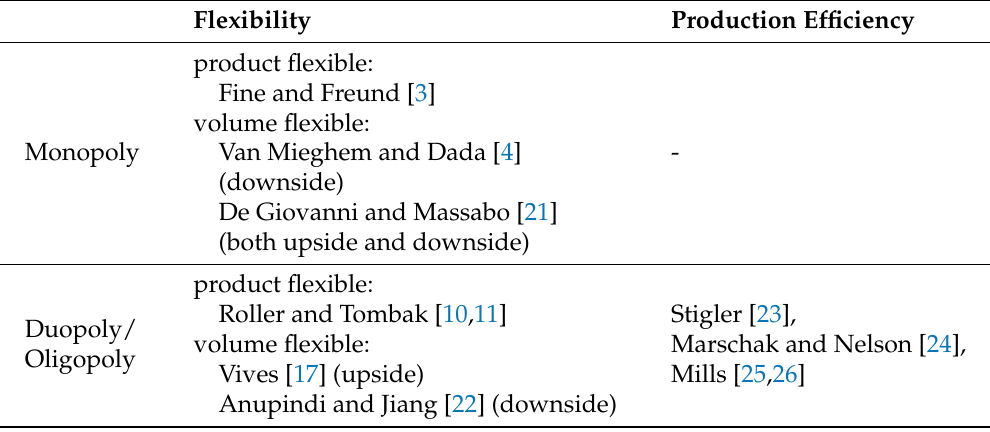
Table 1. Summary of Literature on Flexibility and Production